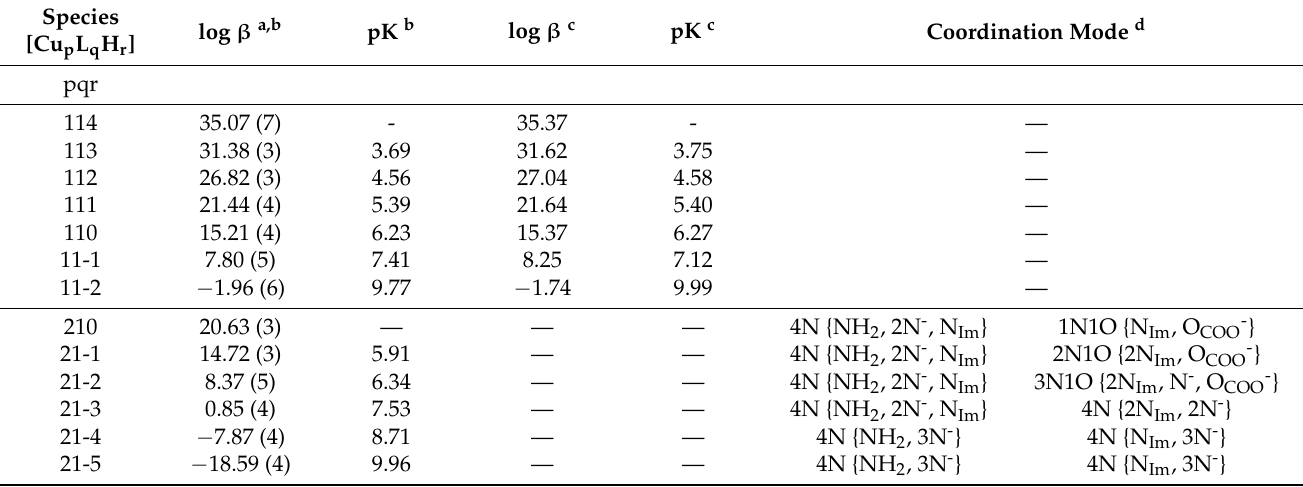
Table 1. Log β and pK values for Cu 2+ complexes with Ctr1 (1-14) at I = 0.1 mol dm − 3 (KNO 3 ) and T = 298